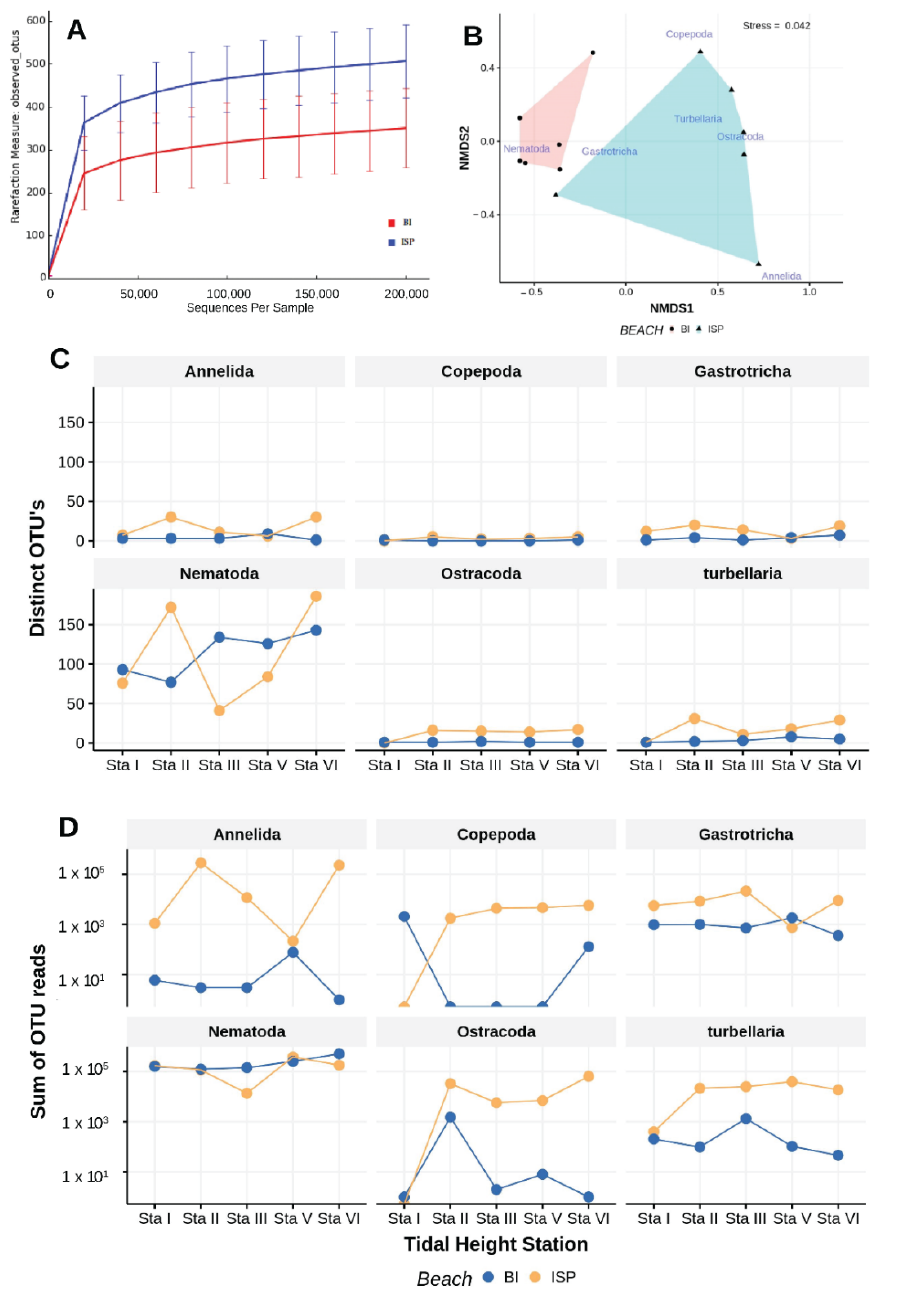
Figure 15. Results of metabarcoding meiofaunal samples collected from unnourished (BI) and previously nourished (ISP) beaches. Rarefaction curves derived from observed OTU's for each beach ( A ). OTU reads ( C ) and number of OTU's ( D ) observed at each tidal height (Sta I—MHW, Sta II—intermediate between MHW and MTL, Sta III—MTL, Sta V—MLW, Sta VI—wave swash) for each beach indicated along with probabilities of separate, paired t -test comparisons for each beach. nMDS ordination for the OTU assemblages ( B ); non-metric scales serve to ease visual estimation of dissimilarity distances but are not associated with any specific units.